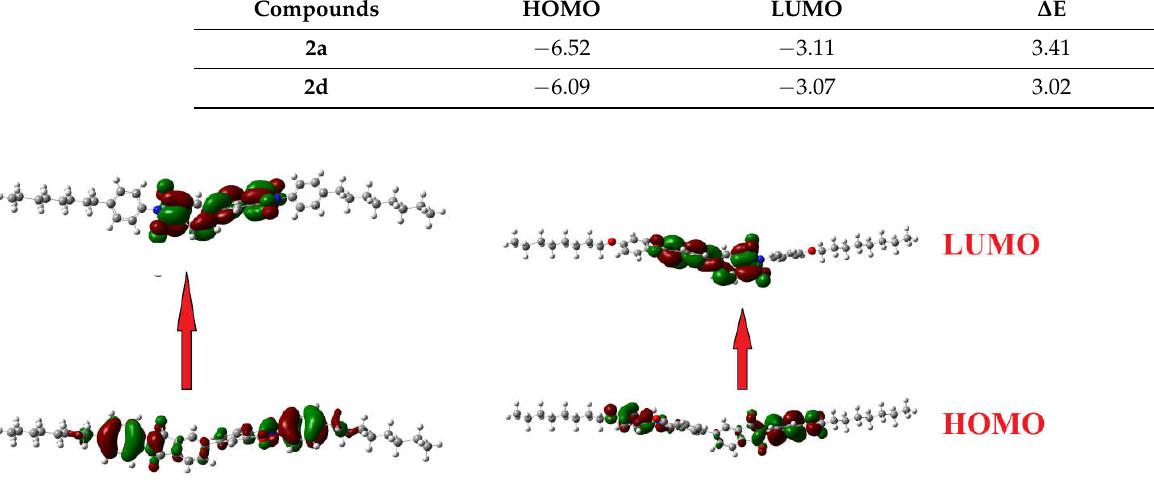
Figure 8. The estimated plots for frontier molecular orbitals of the prepared compounds 2a and 2d .